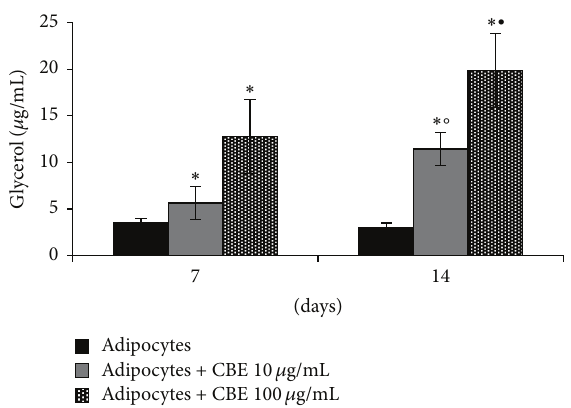
Figure 6: Stimulation of lipolysis by 10 or 100 𝜇 g/mL Citrus bergamia extract (CBE) in 14-day differentiated adipocytes, assessed by the amount of glycerol released into the media. Data were expressed ( 𝜇 g/mL) as mean ± SD from a representative triplicate experiment. ∗ 𝑝 < 0.01 versus the 14-day differentiated adipocytes; ∘ 𝑝 < 0.05 versus CBE 10 𝜇 g/mL at 7 days; ∙ 𝑝 < 0.01 versus CBE 100 𝜇 g/mL at 7